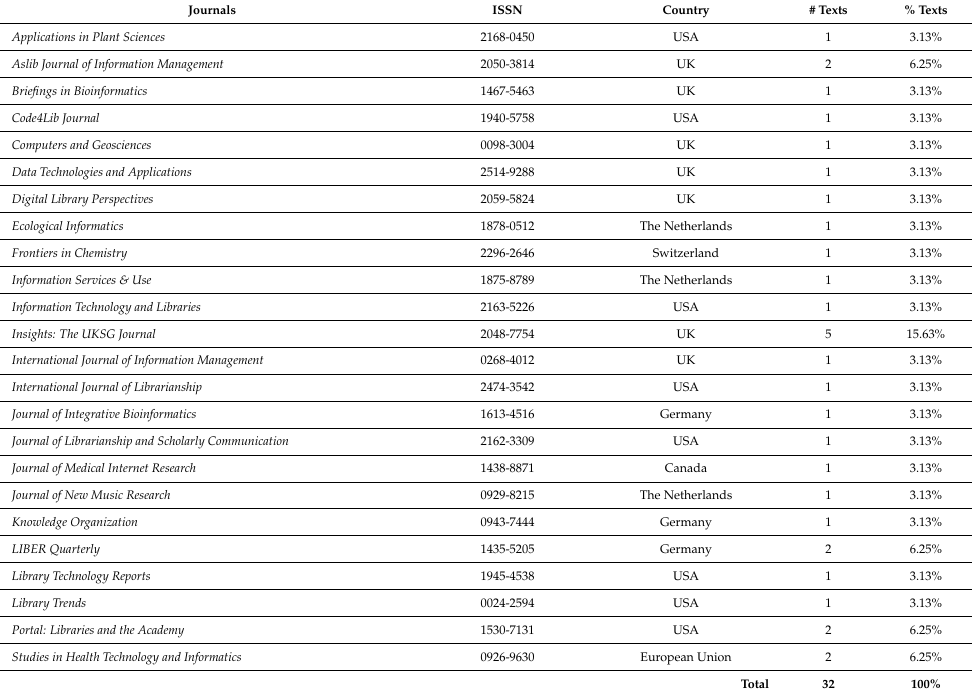
Table A6. Distribution of analyzed papers by scientific journals.